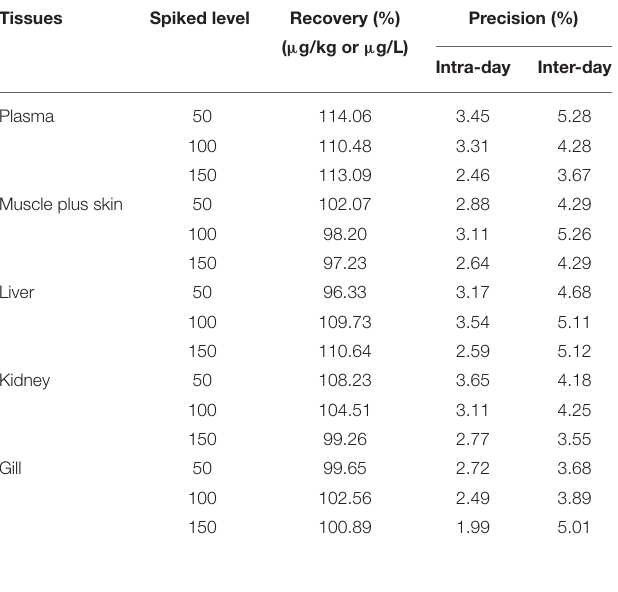
TABLE 1 | Recovery and precision of the method for tiamulin in spiked plasma, muscle plus skin, liver, kidney and gill of Nile tilapia ( n = 6). Tissues Spiked level